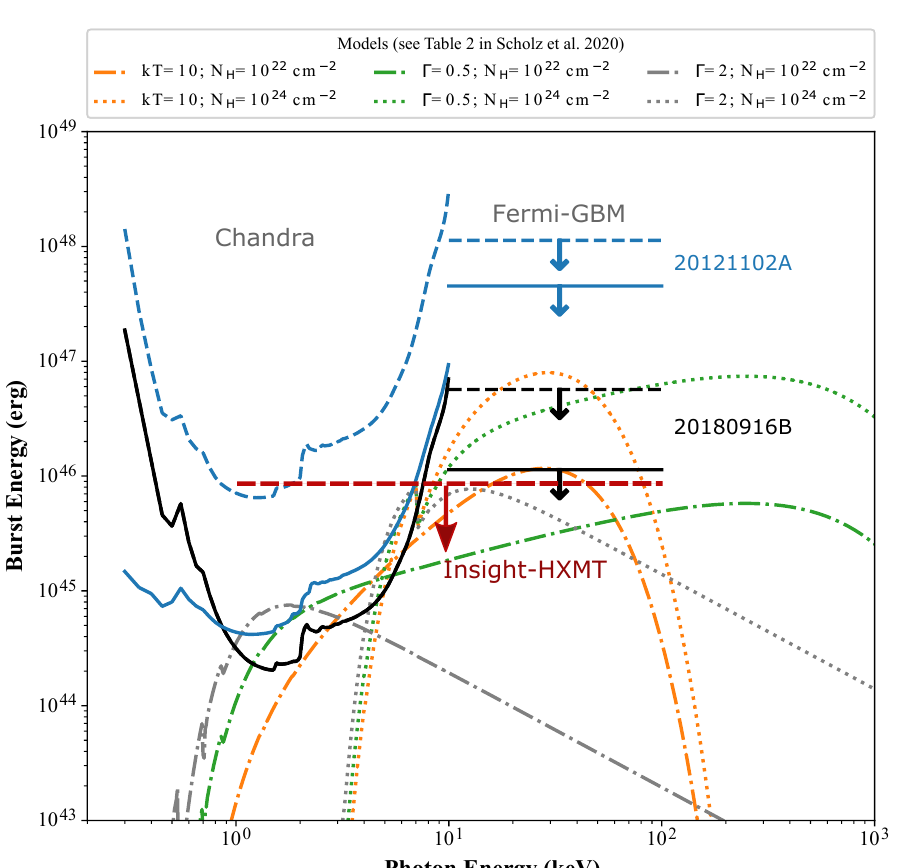
Figure 5. Limits on energy of X-/ γ -ray bursts at the time of radio bursts from FRB 20121102A (blue) and from FRB 20180916B (black) obtained respectively with Chandra (0.5–10 keV), with Fermi /GBM (10–100 keV), and with Insight-HXMT (1–100 keV). Dashed and solid lines are 5 σ upper limits derived on the integration time of a single FRB and stacked ones. Chandra and Fermi limits were derived simultaneously with FRBs, whereas no FRB was reported from FRB 20180916B for the Insight-HXMT one, which is given at 90% confidence and assumes an integration time of 0.1 s (from [26]) (adapted with permission from Scholz, P., et al.; published by IOP Publishing, 2020